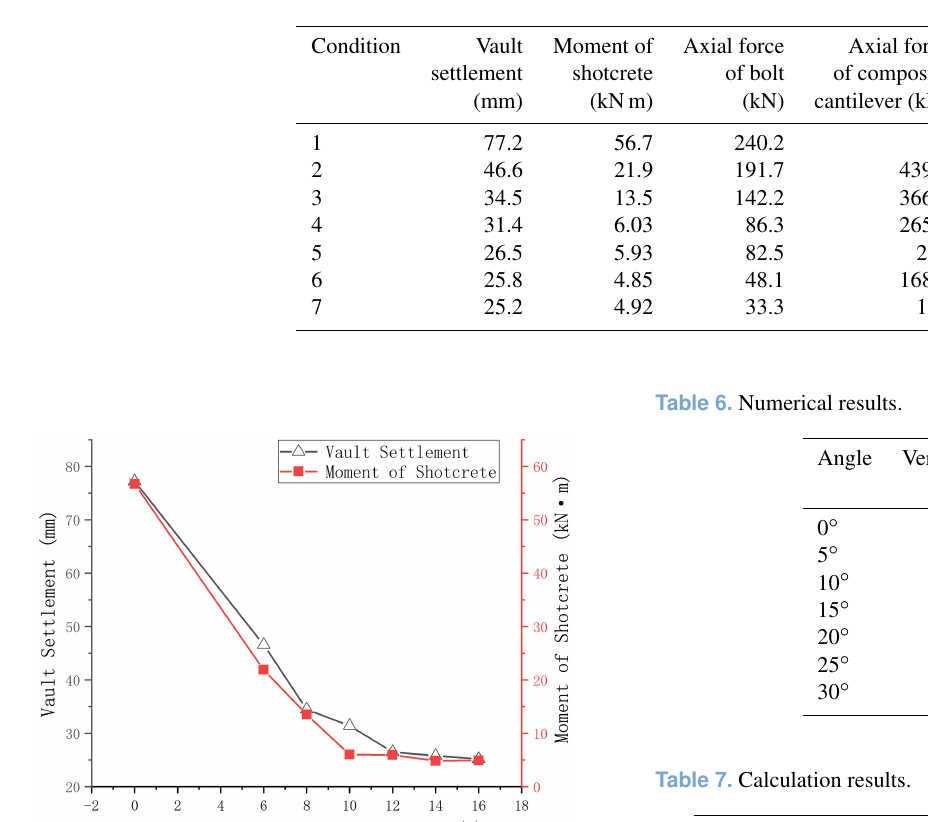
Table 5. Numerical calculation results.